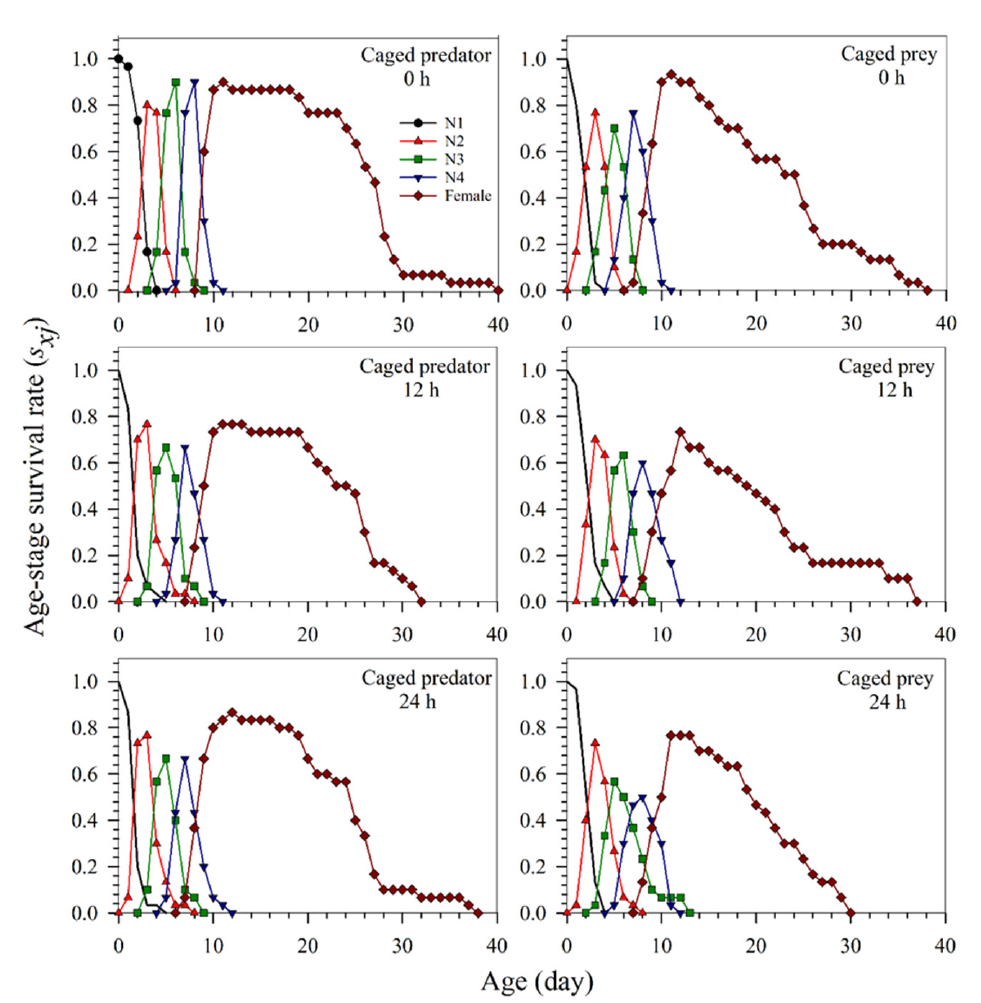
Figure 2. The age-stage specific survival rates ( s xj ) of Sitobion miscanthi under predator Coccinella septempunctata risk at different exposure times (0, 12, and 24 h) with either the caged predator or caged prey treatments. N: Nymphal instar of S. miscanthi. Exposure to the predation risk of the caged predator did not affect the r and λ ; there was no difference between the values obtained in the control (0 h) treatment and the two different exposure treatments (12 and 24 h). However, the R 0 value at the exposure of 12 h and T value at the exposure of 24 h was significantly lower than that in the control treatment ( p = 0.0494; p = 0.0036). Exposure to the predation risk of caged prey significantly affected the population parameters of the pest. Compared to the control treatment, the higher r, λ , and R 0 values at the 12 h and 24 h exposure times ( r : p = 0.0005, p = 0.0016; λ : p = 0.0011, p = 0.0052; R 0 : p = 0.0231, p = 0.0124) and a longer T value at the 12 h exposure time ( p = 0.0202) were obtained (Table